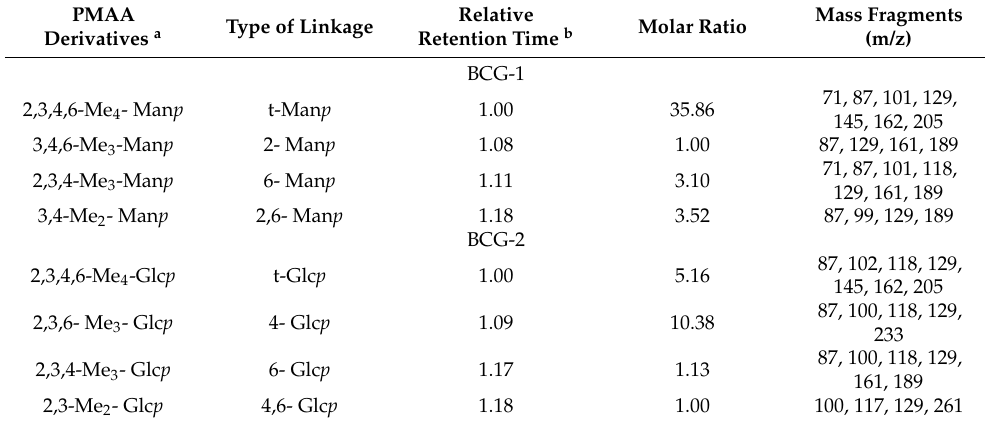
Table 1. GC-MS of alditol acetate derivatives of the BCG-1 and BCG-2 methylated products.